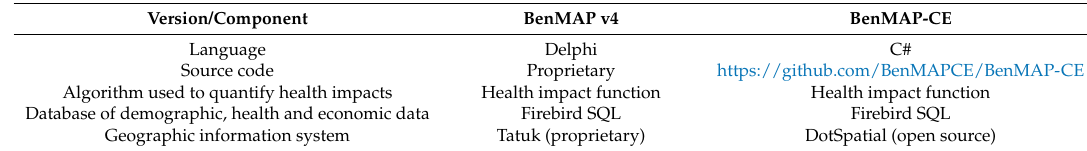
Table 1. Comparison of Benefits Mapping and Analysis Program—Community Edition (BenMAP) v4 and